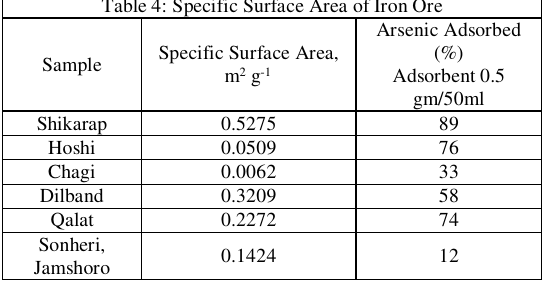
Table 4: Specific Surface Area of Iron Ore